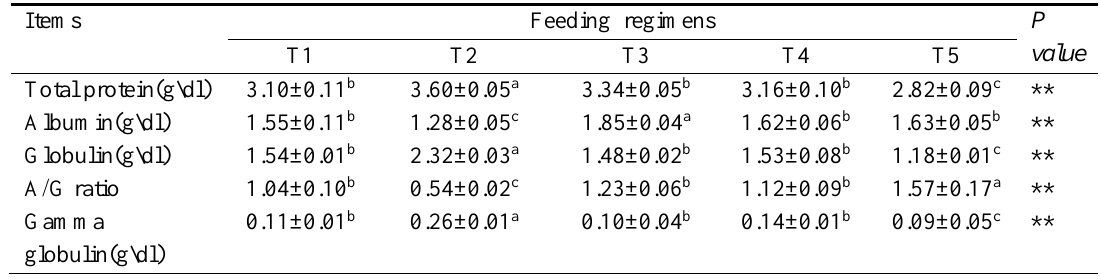
Table 8: Effect of feeding frequency and amount on biochemical parameters of broiler (Means±SE).